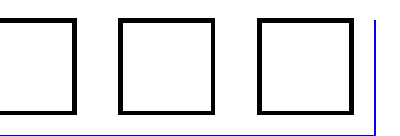
Figure 13. Laser cutting features (blue) to aid alignment of the laser cutter when cutting out the transducers (indicated as black